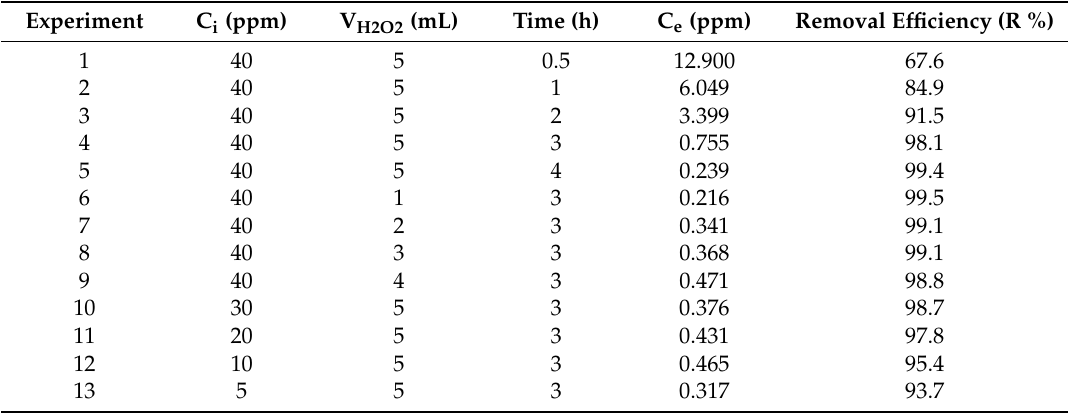
Table 1. Oxidation degradation of methyl orange conditions used and